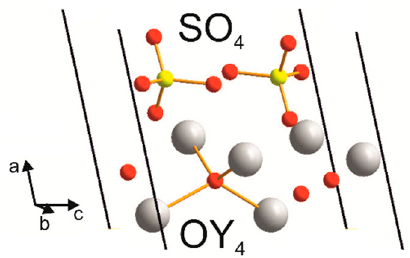
Figure 5. AB 4 ( A = S, O; B = O, Y) structural units in Y 2 O 2 SO 4 .